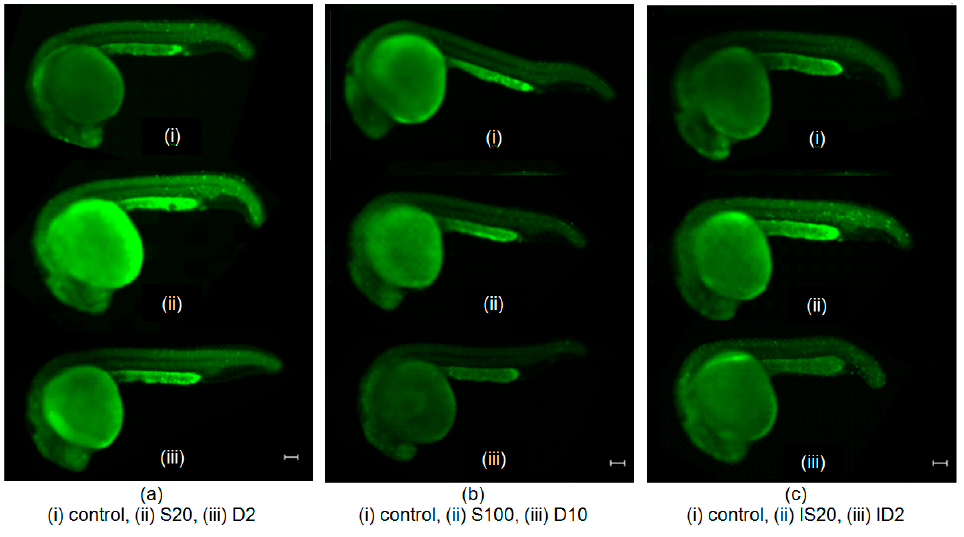
Figure 2. Cont. Figure 2.